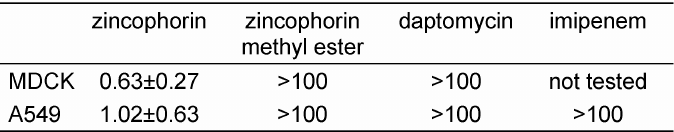
Figure 3: Dose dependence of the effect of zincophorin on growth and biofilm formation of S.pneumoniaeDSM20566. Mean values of the inhibitory effect in % with standard deviation of at least 3 tests each with 2 parallels are shown. Table 3: Cytotoxicity of zincophorin, zincophorin methyl ester, daptomycin, and imipenem. Mean values of the 50% cytotoxic concentrations in µM (CC ) with standard deviation are 50